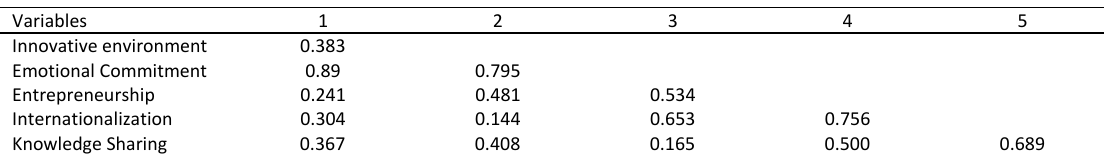
Table 2: Divergent